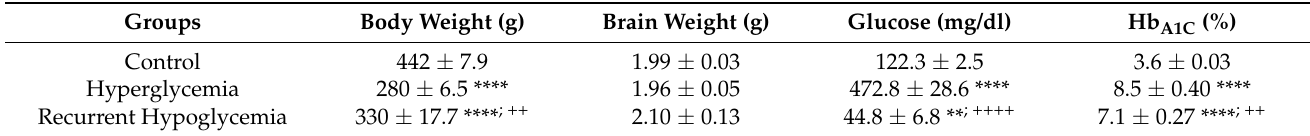
Table 1 . Characterization of the experimental animal models. Table 1. Characterization of the experimental animal models.